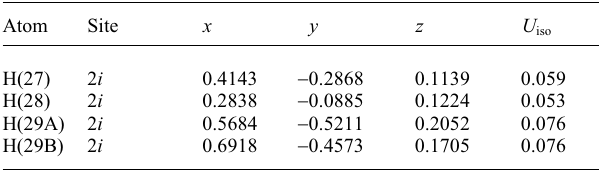
Table 3. Atomic coordinates and displacement parameters (in Å 2 )